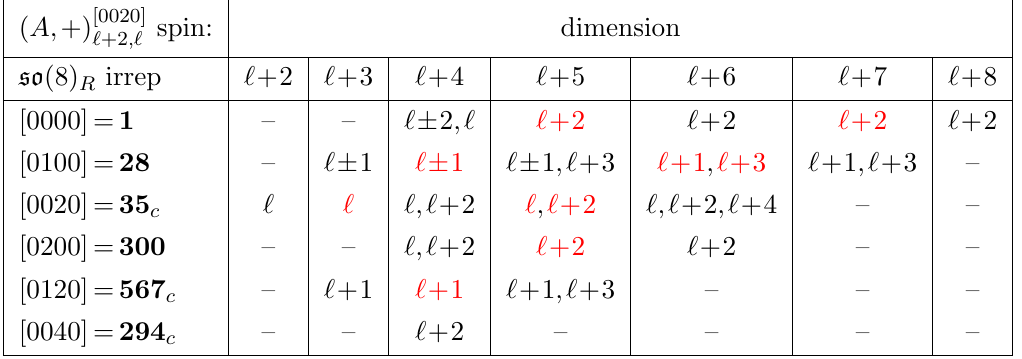
Table 24 . All possible conformal primaries in S 2 (cid:2) S 2 and S 3 (cid:2) S 3 corresponding to the ( A; +) [0020] superconformal